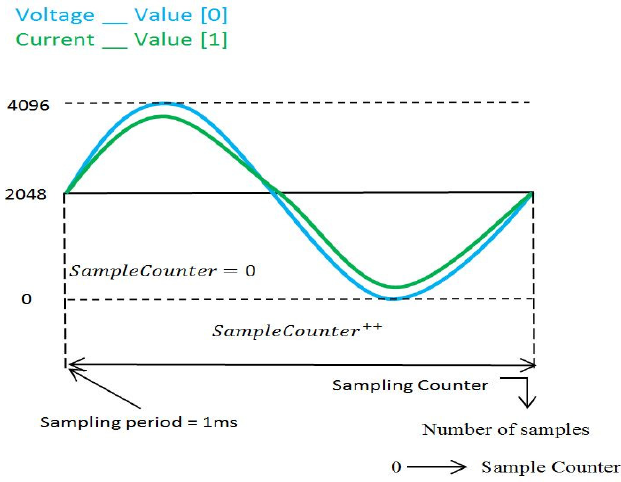
Figure 5. Domain and frequency definition on a 12 bit analog-to-digital conversion board (ADC).